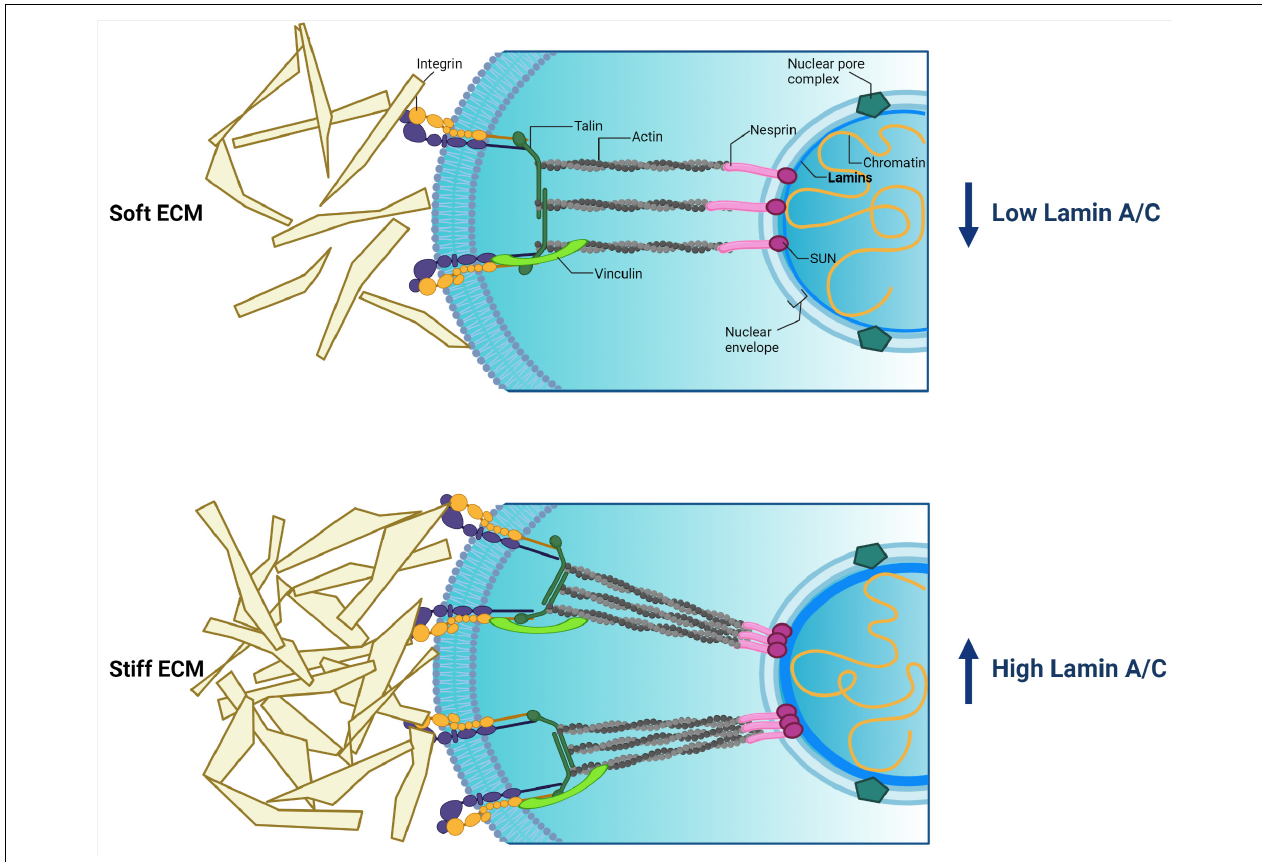
FIGURE 6 | Cytoplasmic and nuclear components involved in mechanotransduction and their relations. External stimuli coming from extracellular matrix (ECM) pass to cytoplasmic membrane integrins. Then the signal transmits though focal adhesion proteins (talin, a-actinin, vinculin) toward actin. Actin directly binds with the LINC complex (nesprin + SUN + lamins), resulting in the signal being transmitted into the nucleus. The force of external stimuli affects lamin A/C production, thereby driving nucleus stiffness and protecting the genome. Created with